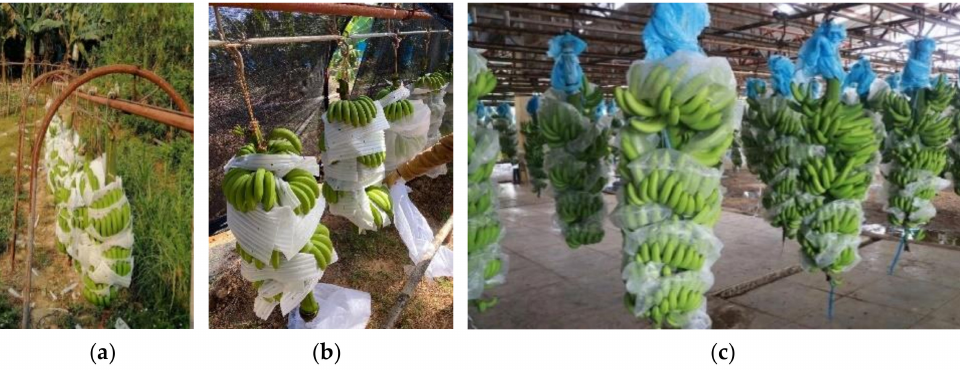
Figure 5. Ropeway transportation of banana bunches: ( a ) transportation in banana orchard; ( b ) transportation in the fixed collecting stations of the orchard; and ( c ) transportation in the post-harvest commercial processing